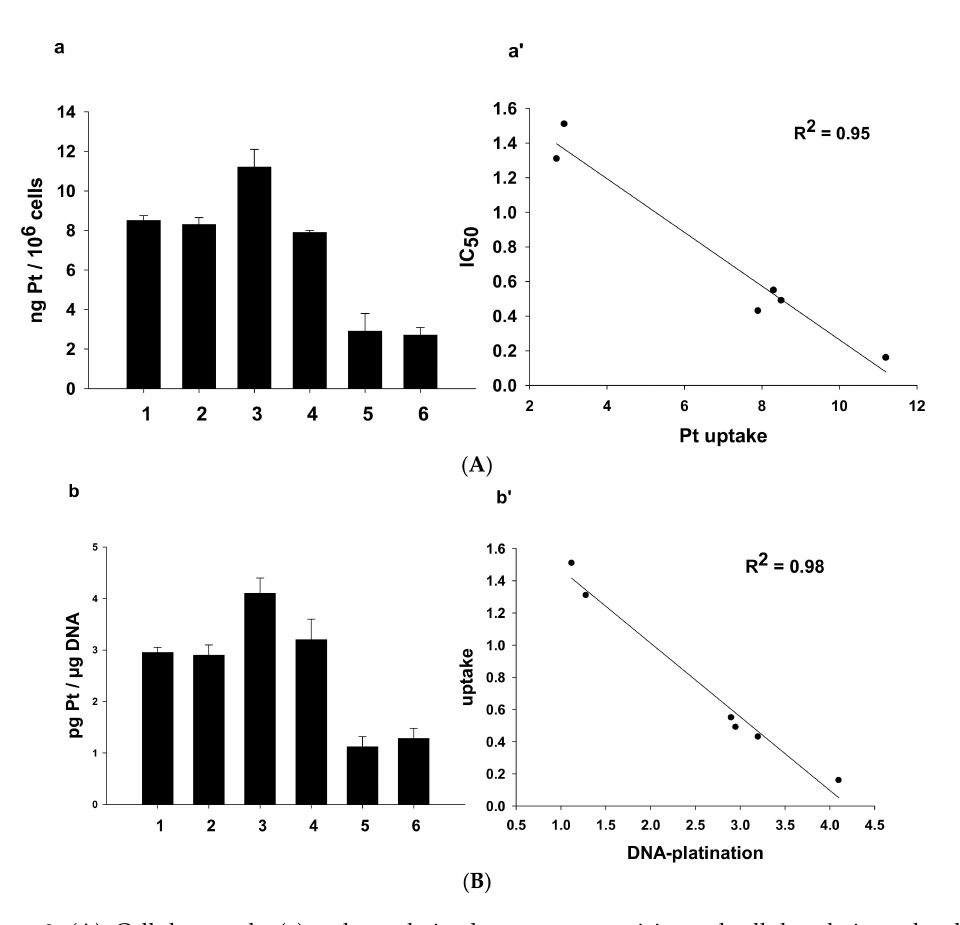
Figure 9. ( A ). Cellular uptake (a) and correlation between cytotoxicity and cellular platinum levels (a’) in treated A431 cancer cells. A431 cells were incubated for 24 h with 0.5 µ M of 1 – 6 . The error bars indicate standard deviation (SD). ( B ). Nuclear DNA platination levels (b) and correlation between cellular uptake and DNA-platination levels (b’) in drug-treated A431 cells. A431 cells were treated for 24 h with 0.5 µ M of 1 – 6 . DNA was extracted and quantified, and the amount of Pt bound to DNA was estimated using graphite furnace atomic absorption spectrometry (GF–AAS). Error bars indicate SD. Both Pt(IV) asymmetric derivatives 5 and 6 were the worst in crossing the cell